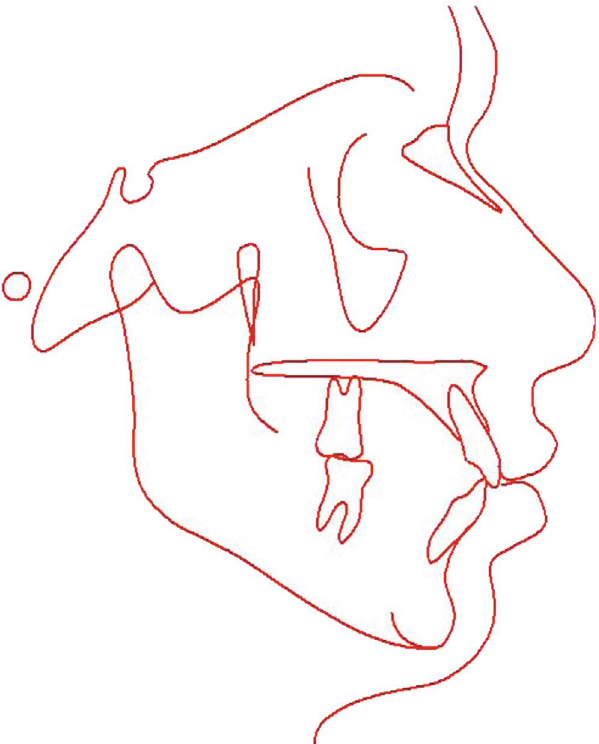
Figure 13: Final cephalometric